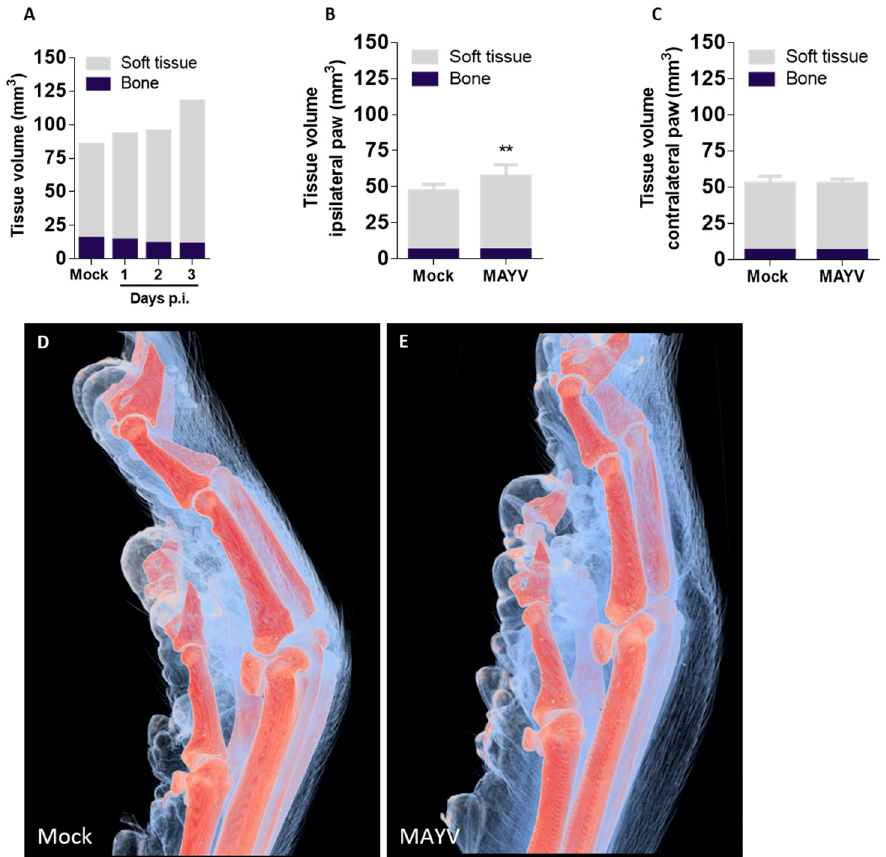
Figure 4. Microtomographic analysis allows precise quantification and localization of edema in paws of MAYV-infected mice in 3D. Three-dimensional reconstructions of mice hind paws were segmented into soft tissue and bone, and tissue volumes were calculated. ( A ) Tissue volumes of mock- and MAYV-infected mice paws at days 1 to 3 p.i. showing increased edema in soft tissues throughout infection. Volumes of soft tissue and bone at day 3 p.i. were also measured in ( B ) ipsilateral (injected) and ( C ) contralateral (non-injected) paws in the same mouse. ( D , E ) Visualization of 3D reconstructed paws of ( D ) mock- and ( E ) MAYV-infected mice with segmented soft tissue (blue) and bone (orange). Edema is visible in the MAYV-infected paw, where we observe swollen soft tissue compared to the mock control. Data presented as mean ± SEM. ** p <=